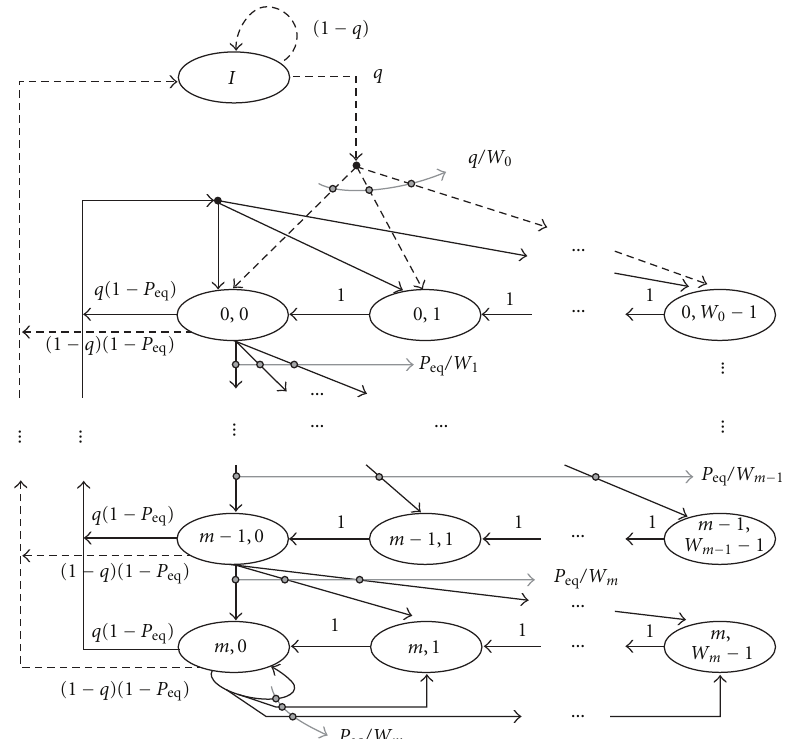
Figure 1: Markov chain for the contention model accounting for unsaturated tra ffi c conditions. The model considers m backo ff stages. P eq is the probability of failed transmission, accounting for both collisions and channel errors a ff ecting the transmitted